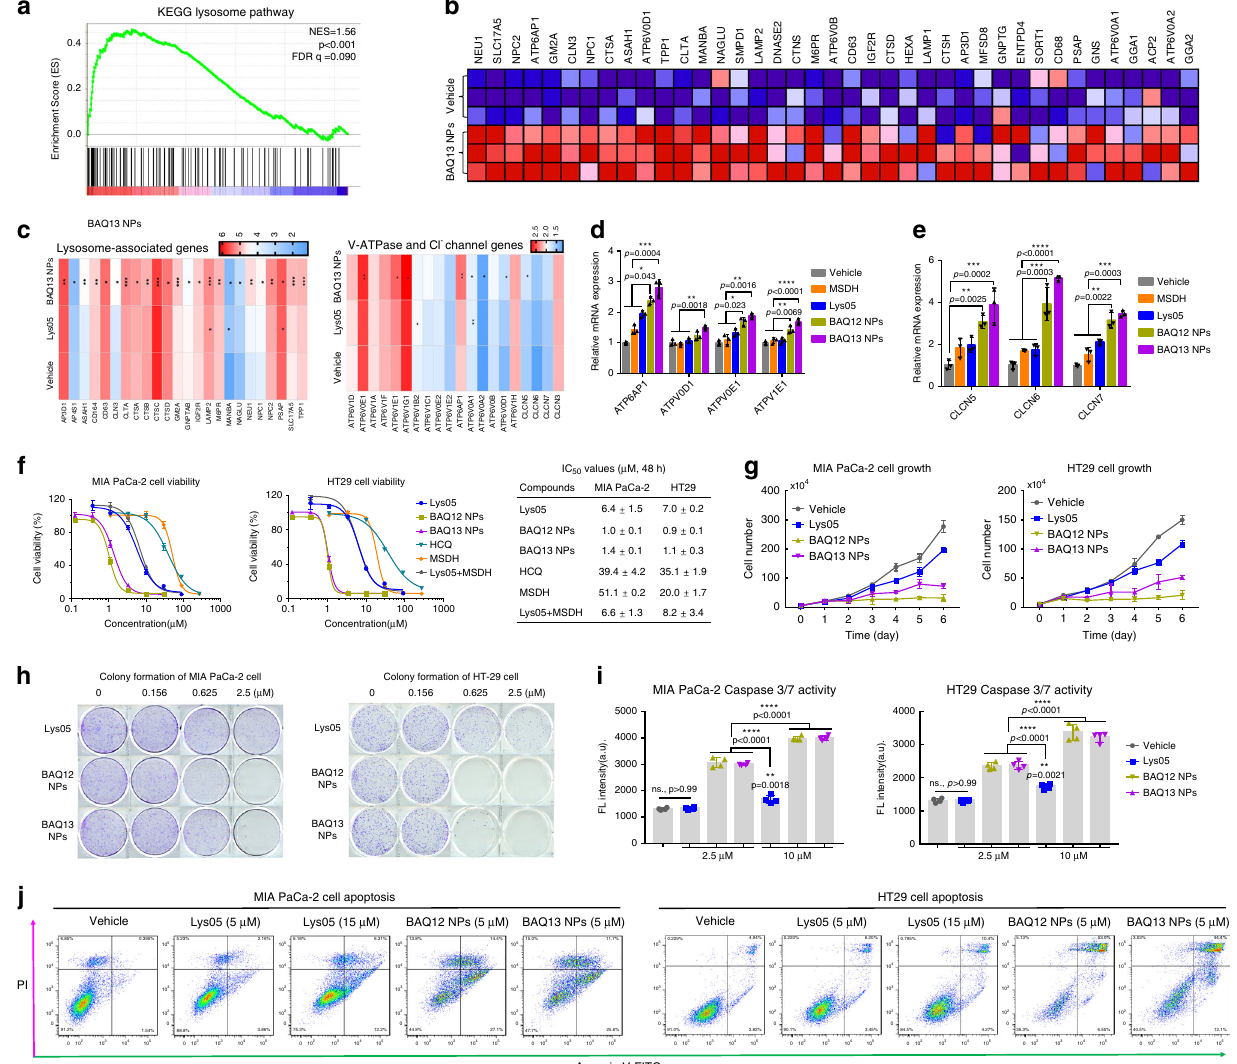
Fig. 4 BAQ ONNs altered the expression of lysosomal genes and caused cell death via apoptosis. a GSEA demonstrating the enrichment of lysosomal gene sets in MIA PaCa-2 cells treated with BAQ13 NPs (5 µ M, 24h). GSEA was performed with n = 1000 permutations, where p adjust<0.05 and FDR<0.05 were considered signi fi cant. b Representative upregulated lysosomal genes from a . c Comparison of gene upregulation between Lys05 and BAQ13 NPs. d , e qPCR analysis of V-ATPase genes ( d ) and Cl − channel genes ( e ) involved in the indicated treatments (5 μ M, 24h); data are mean values±SD; n = 3. f Viability curves of cells that were exposed to the 48h treatments and the corresponding IC 50 values; data are mean values±SD; n = 3. g MIA PaCa-2 (1.5 µ M) and HT29 (1.0 µ M) cell growth curves within continuous treatments; data are mean values±SD; n = 3 independent experiments. h Clonogenic assay of MIA PaCa-2 and HT29 cells; n = 3. i Caspase 3/7 activity in MIA PaCa-2 and HT29 cells that were treated for 6 and 12h, respectively; Data are mean values±SD; n = 4. j Percentage of apoptotic population of MIA PaCa-2 (left) and HT29 (right) cells that were treated for 24h. All the statistical p values were calculated by one-way ANOVA with the Tukey ’ s multiple comparison test; ns not signi fi cant; * p <0.05; ** p <0.01; *** p <0.001; **** p